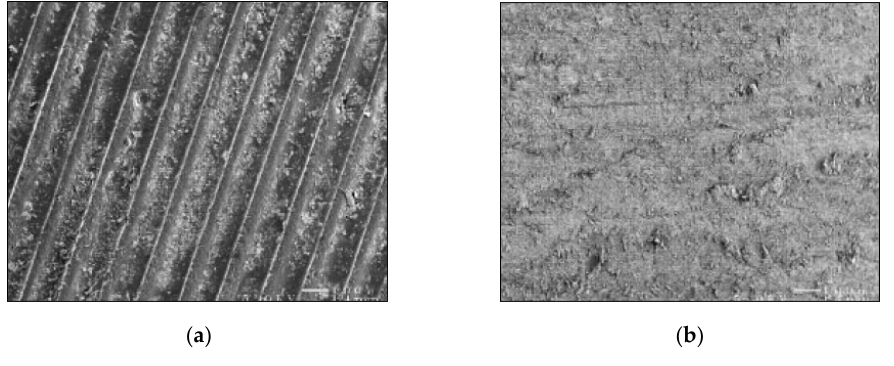
Figure 5. Surface finish: ( a ) before and ( b ) after the AFF process [17].